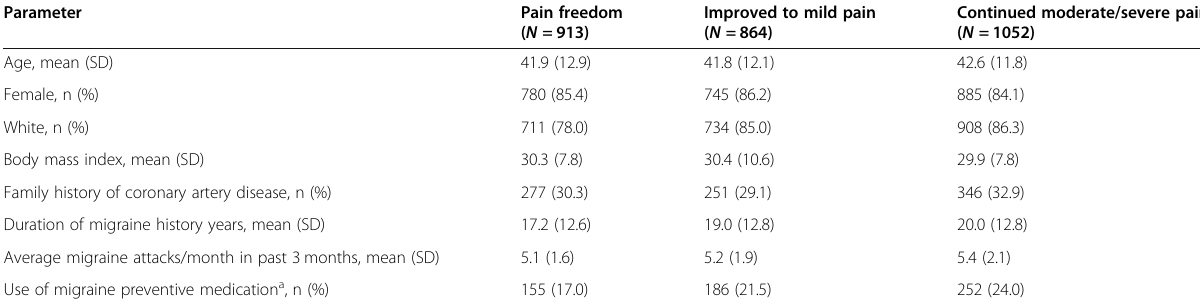
Table 1 Patient baseline demographics by head pain outcome group at 2 h post-dose Parameter